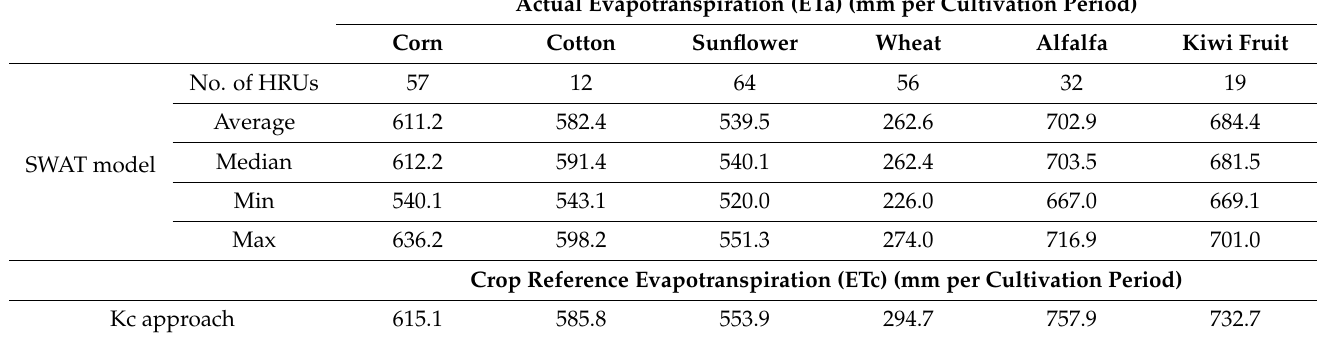
Table 1. Comparison of ETa for the dominant crops of the study area, as simulated by SWAT, and ETc as calculated using the Kc approach for two cultivation periods